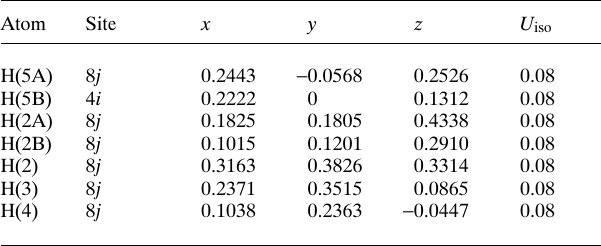
Table 2. Atomic coordinates and displacement parameters (in Å 2 )